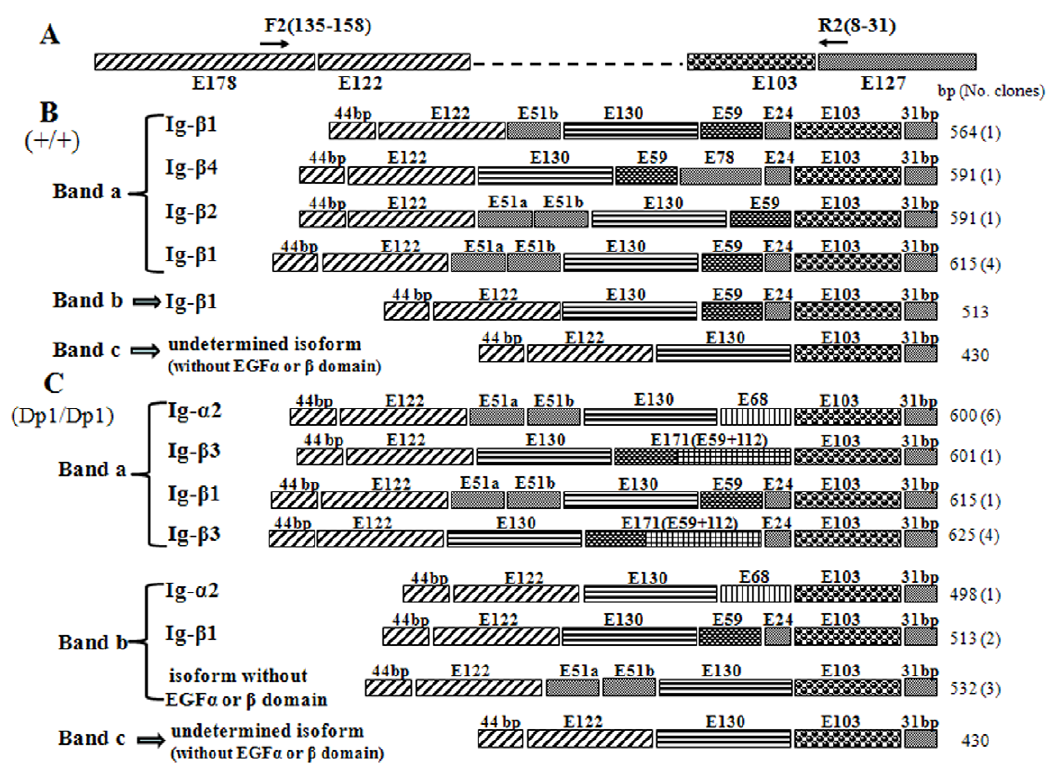
Figure 5. Transcripts of Ig-Nrg1 and the expected protein isoforms produced by wild-type and Dp1/Dp1 homozygous mice. (A) RT-PCR amplified region of Ig-Nrg1 transcripts. The primers used for RT-PCR are indicated; the arrow indicates the approximate primer position within the exon. (B) Transcripts of Ig-Nrg1 produced by wild-type mice. (C) Transcripts of Ig-Nrg1 produced by Dp1/Dp1 homozygous mice. In band a, three kinds of transcripts (accounting for 11/12 of the clones) bypass the mutated splice donor site by either splicing over exon E59, activating a cryptic splice site, or transcribing through exon E59 into the adjacent 112 bp sequence (one transcript, accounting for 6/12 of the clones, is expected to produce Ig- a 2 type isoforms). In band b, two kinds of transcripts (accounting for 4/6 of the clones) bypass the mutated splice donor site by splicing over exon E59 (one transcript, accounting for 1/6 of the clones, is expected to produce Ig- a 2 type isoforms and the other transcript, accounting for 3/6 of the clones, is expected to produce isoforms without the EGF b and EGF a